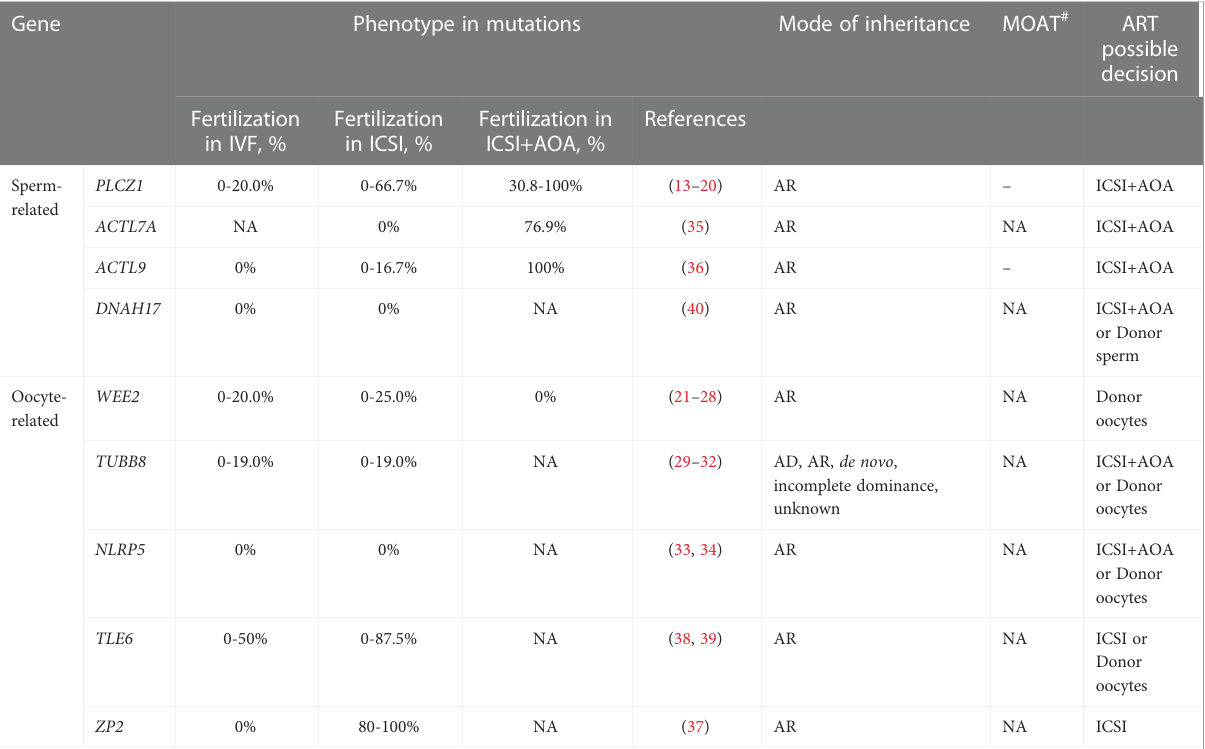
TABLE 3 Summary of gene mutations associated with poor or failed fertilization after IVF/ICSI and ART possible